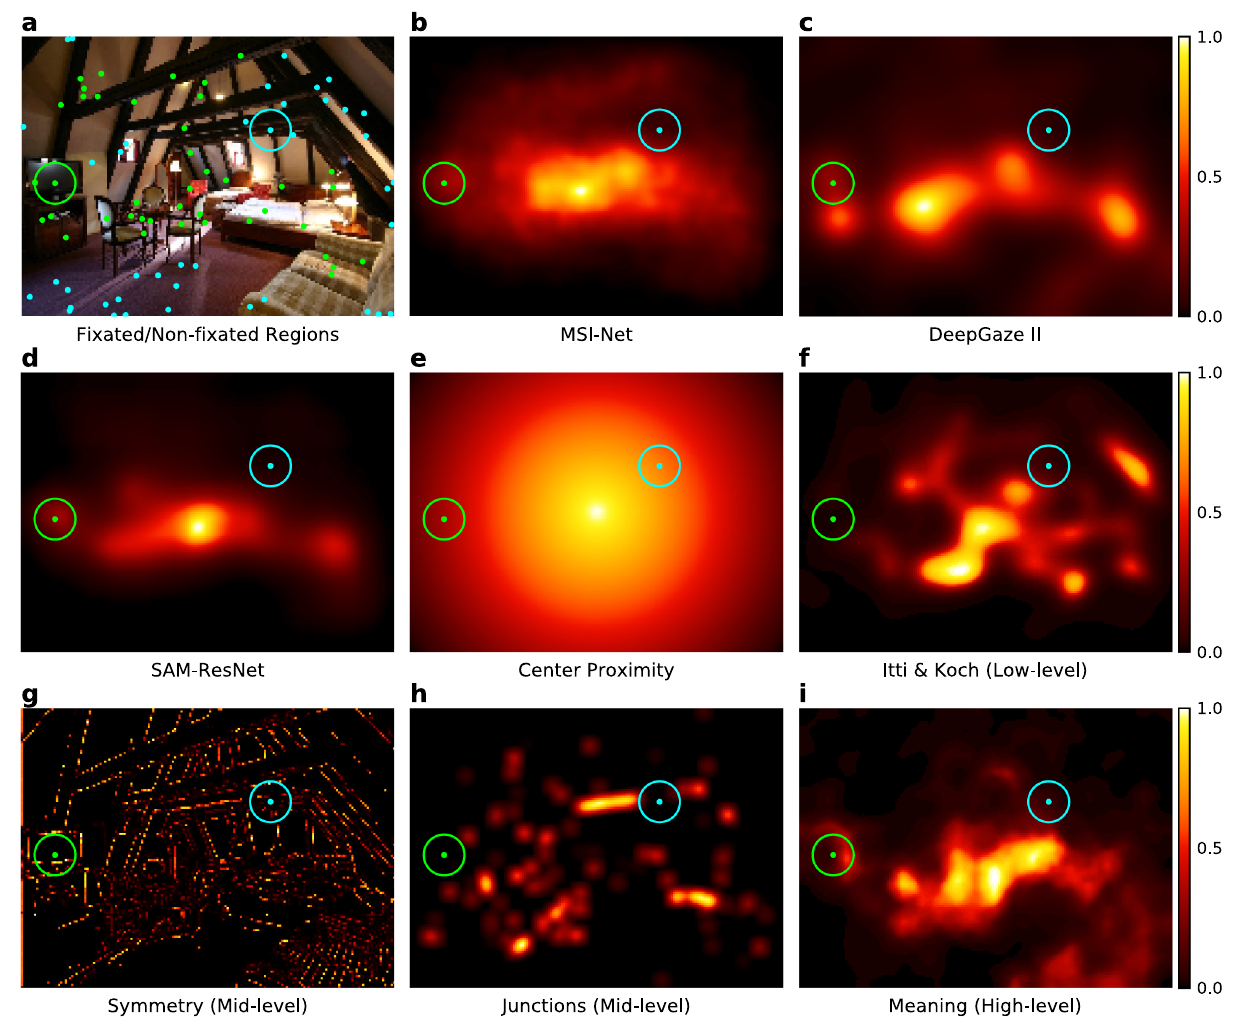
Figure 1. Scene with the fixated and non-fixated regions for a typical subject, and the corresponding deep saliency and feature maps. ( a ) The solid green dots show the scene locations where the subject fixated, and the solid cyan dots indicate randomly sampled non-fixated regions that represent where this subject did not look in this scene. Together these locations provide an account of the regions in this scene that did and did not capture this subject’s attention. Each fixated and non-fixated location was then used to compute a mean value for each deep saliency model map ( b – d ) and feature map ( e – i ) across a 3 ◦ window (shown as circles around one example fixated and non-fixated location in each map). All the heat maps were scaled (0–1) and plotted in Matplotlib 45 (3.4.2, https:// matpl otlib. org/) from their respective source maps (see “Methods” for